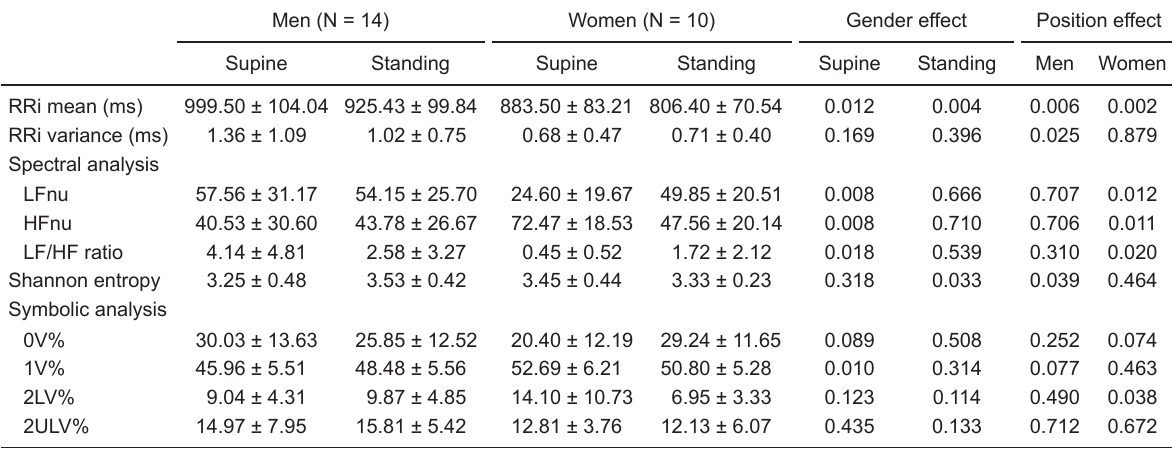
Table 2. Heart rate variability determined by spectral and symbolic analysis in the supine and standing